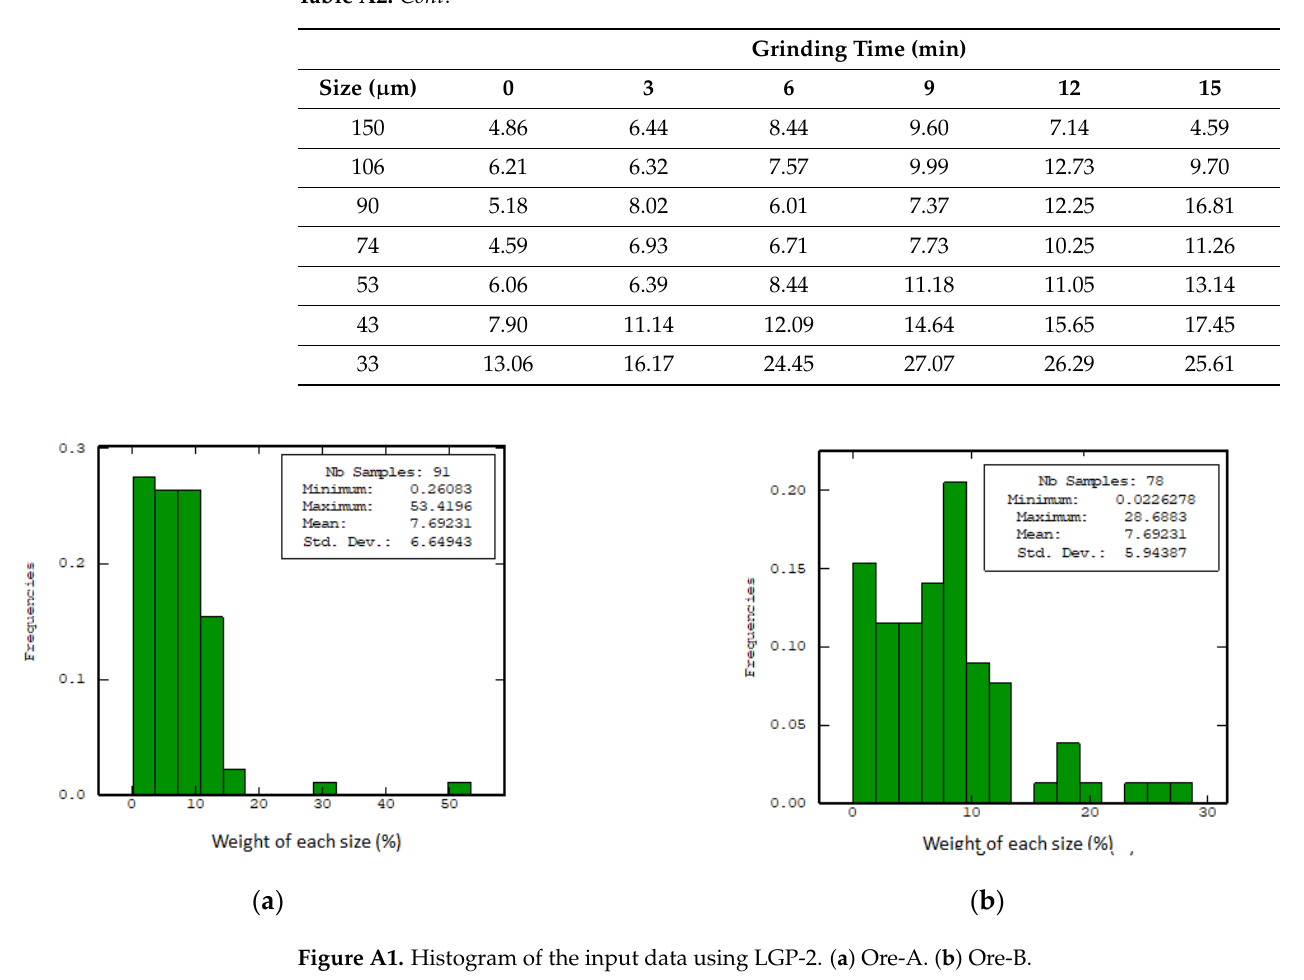
Table A2. Experimental data for the weight of each sizer (%) for LGP-1 ore-B.